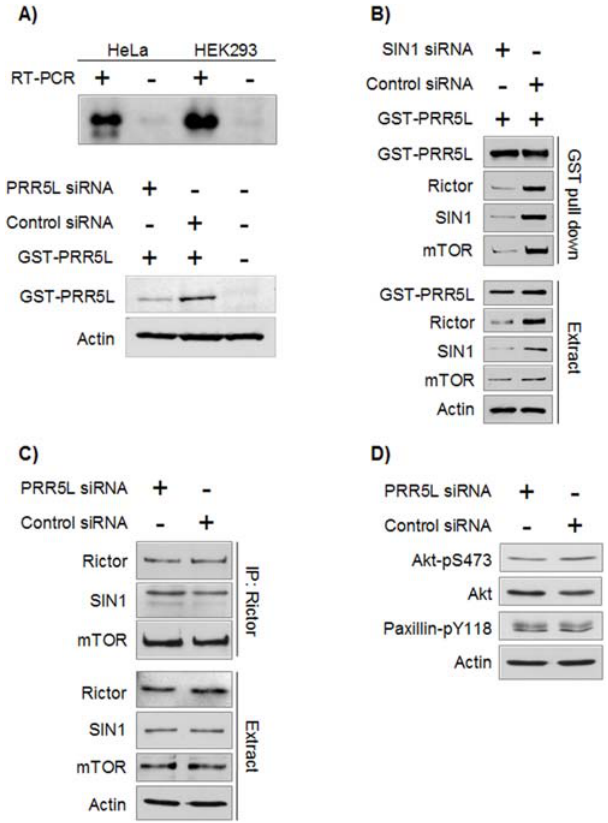
Figure 5. PRR5L binds to mTORC2 via SIN1 and/or Rictor but does not affect mTORC2 integrity or kinase activity. A. PRR5L expression in HeLa and HEK293 cells, and PRR5L knock down efficiency. Top panel: Total RNA was purified from HeLa or HEK293 cells, followed by reverse transcription and PCR with primers corresponding to PRR5L. As a negative control, reverse transcription without the transcriptase enzyme was performed. Endogenous PRR5L is expressed in both cell lines. Bottom panel: HEK293 cells were cotransfected with a GST-PRR5L vector and PRR5L siRNA or control siRNA, and incubated for 48 h. Immunoblots were performed on with antibody against GST or Actin. B. PRR5L binds mTOR via SIN1 and/or Rictor. HEK293 cells were cotransfected with a GST-PRR5L vector and a SIN1 siRNA vector or